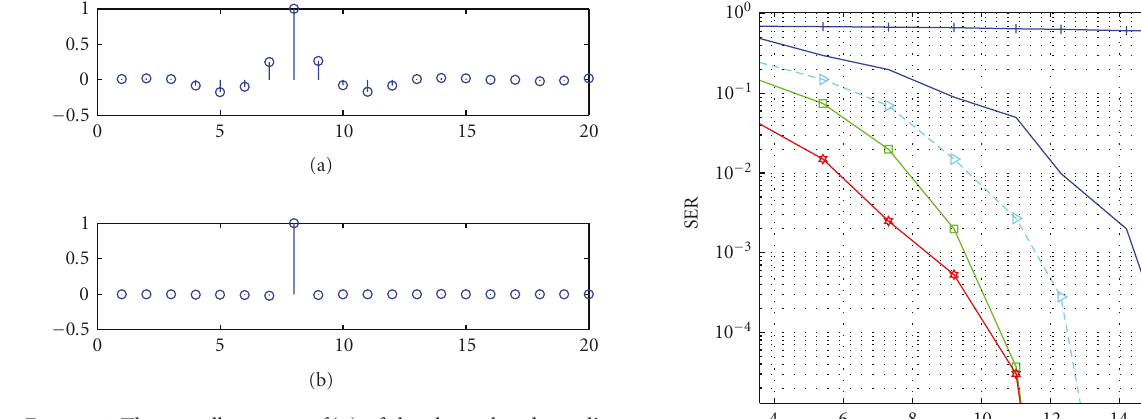
Figure 4: The overall response f ( n ) of the channel and equalizer for colored input (a) based on TX’s CMOV algorithm, (b) Proposed algorithm.